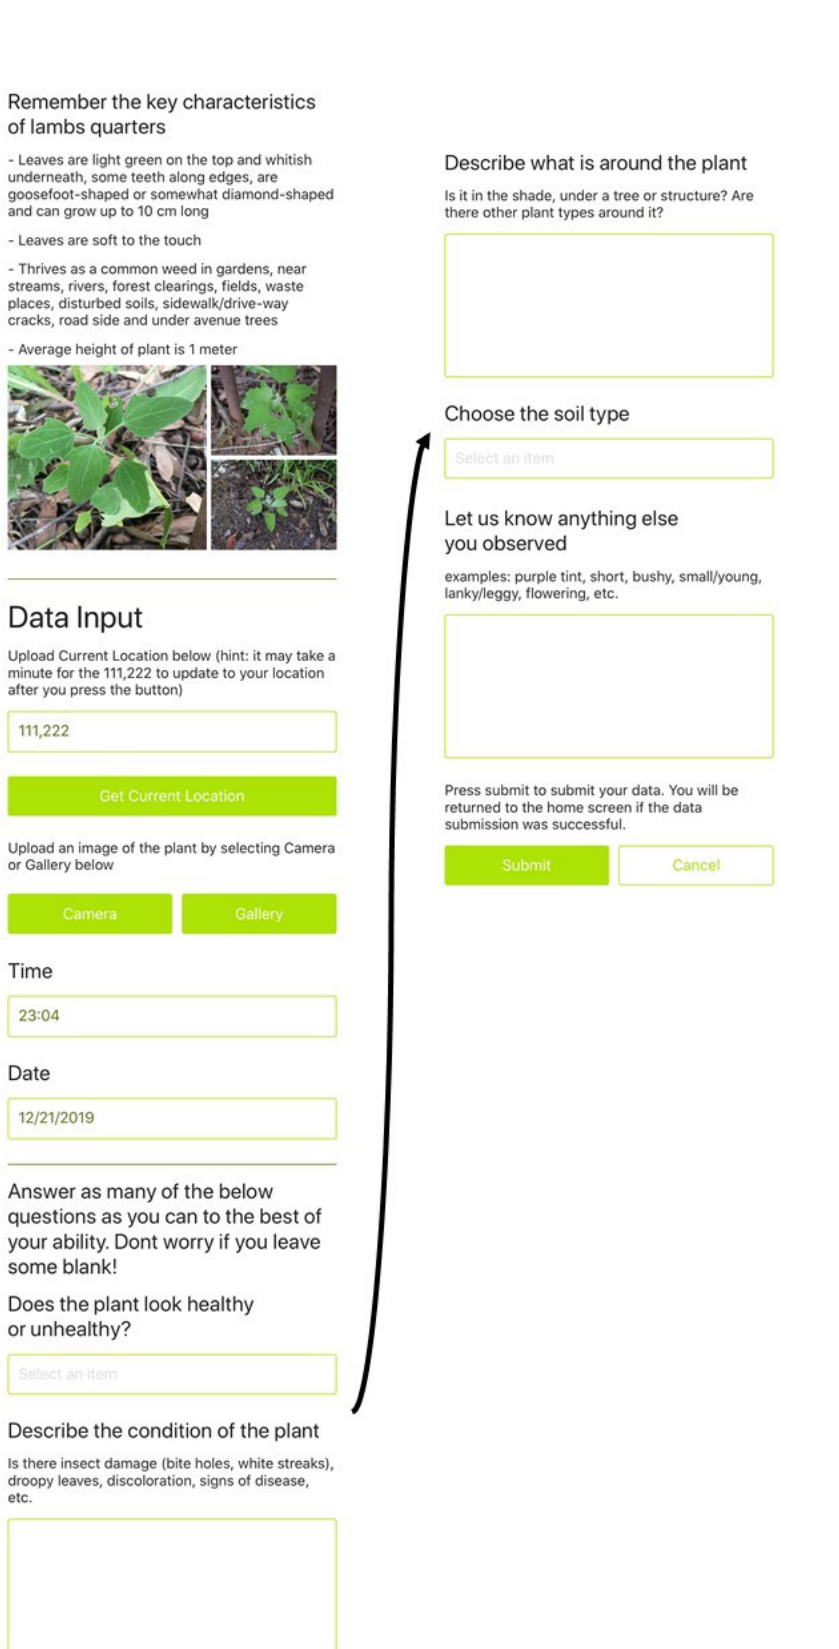
Figure 6. Data submission form for the second design iteration for the iPhone version of Mission